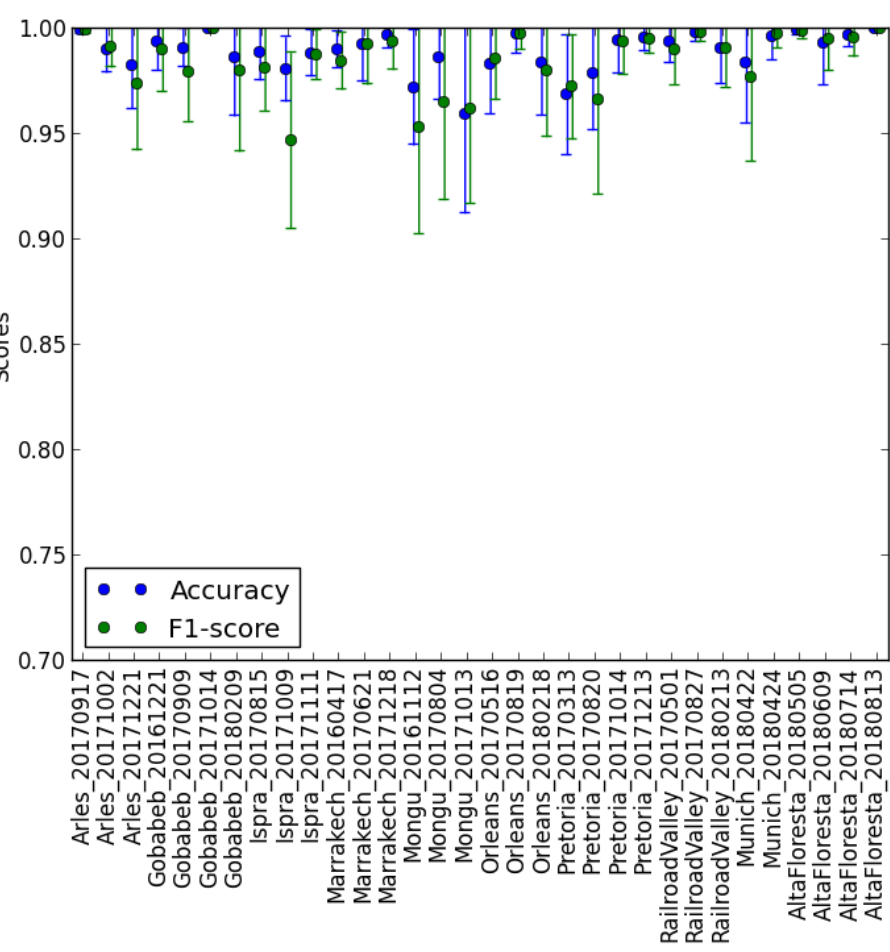
Figure 5. Mean and standard deviation for the overall accuracy and F1-score of a 10-fold cross-validation procedure for each